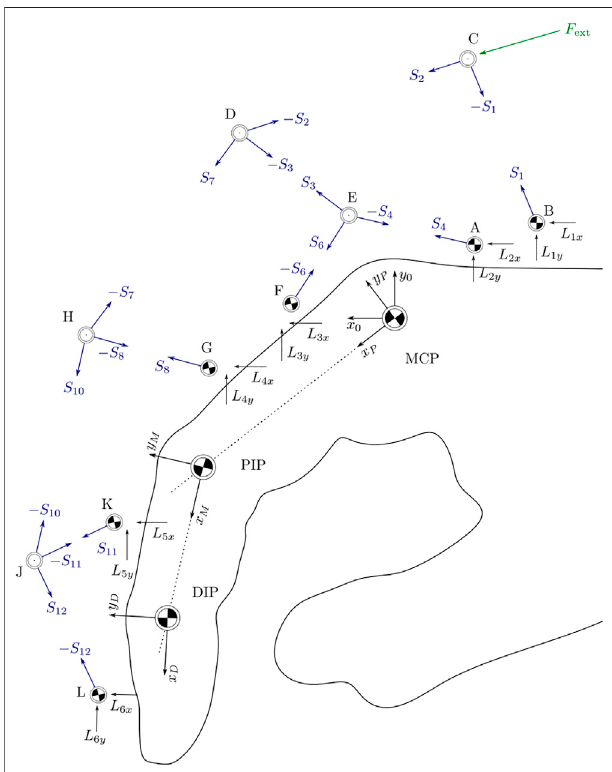
FIGURE 4 | Orientation of all acting forces in space as the basis for equilibrium equations for each joint.